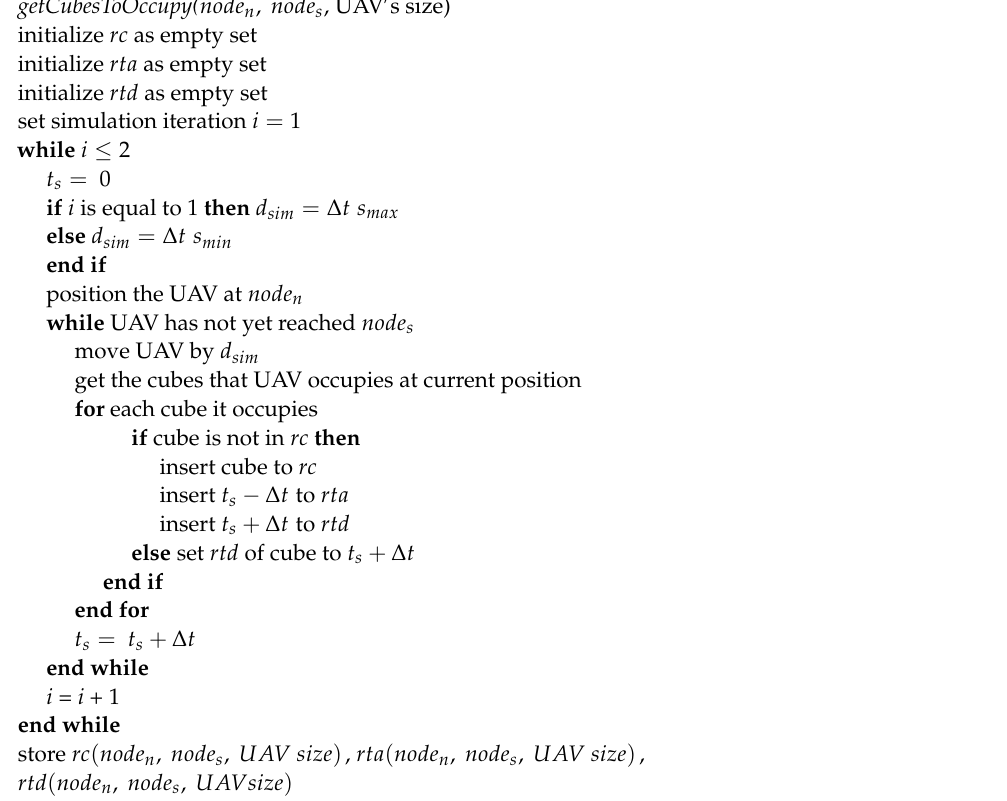
Algorithm 4 Simulation to determine the cubes a UAV will occupy when it travels from node n